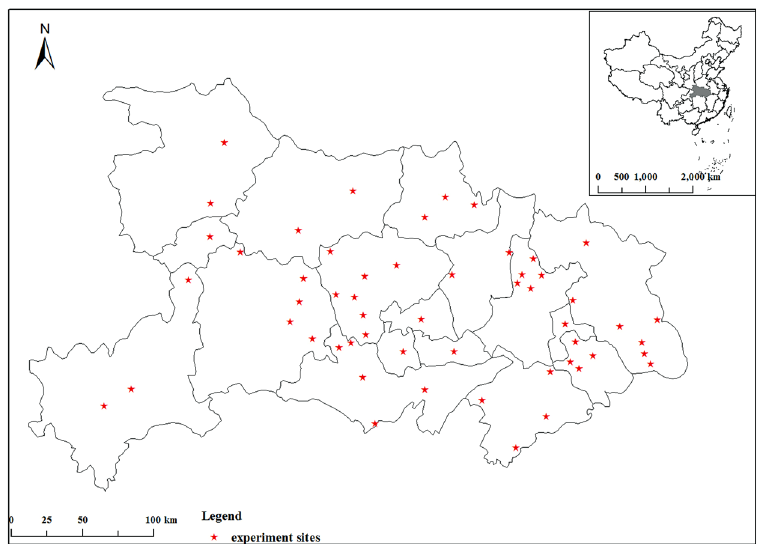
Figure 5. Location of experiment field site.